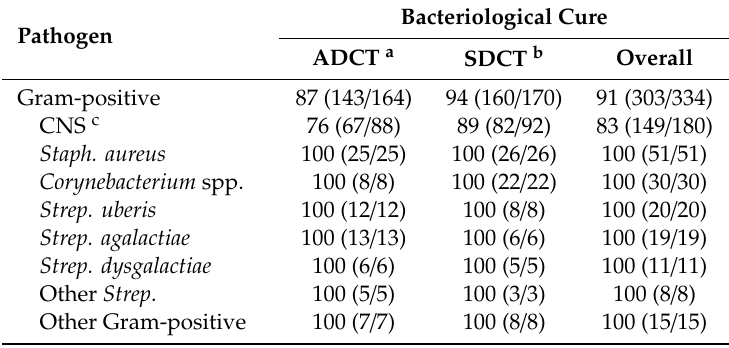
Table 5. Risk (overall and pathogen) of bacteriological cure of mammary quarters submitted to drying o ff